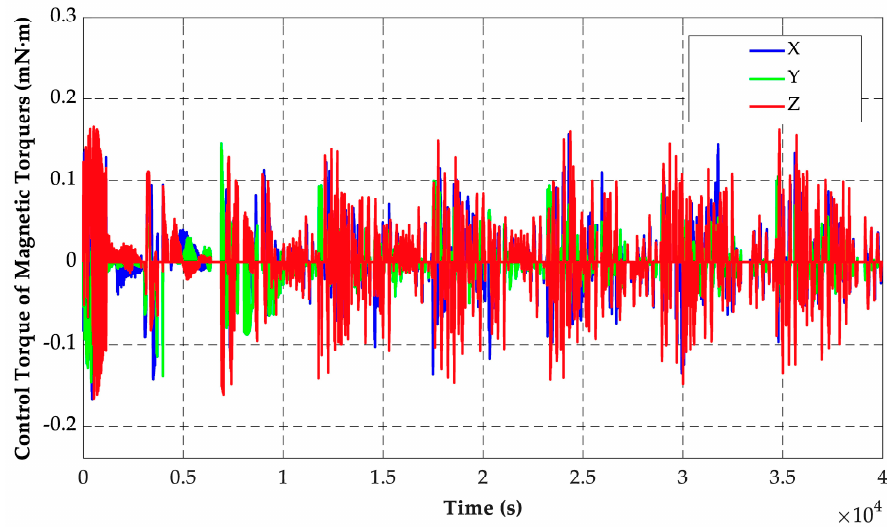
Figure 7. Control torque outputted by 3-axis MTQs.